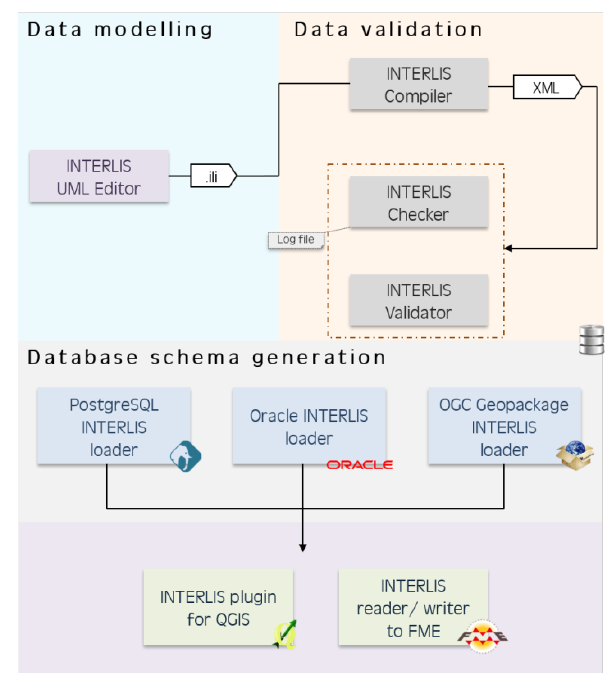
Figure 1. INTERLIS